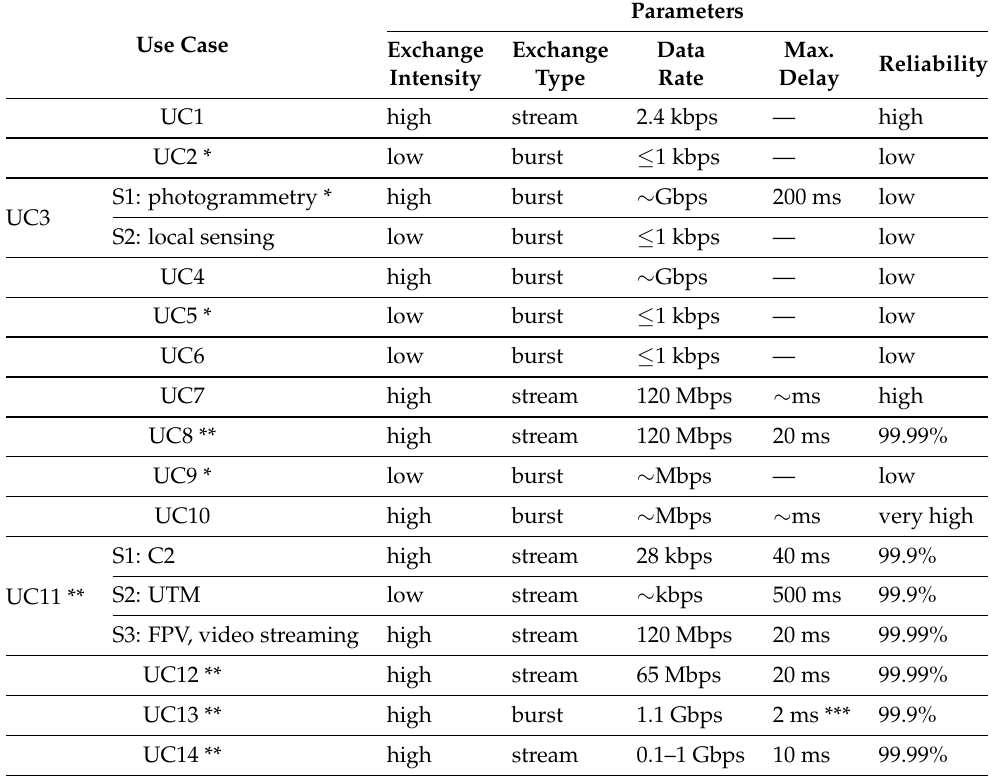
Table 2. Peak service requirements for the analyzed use